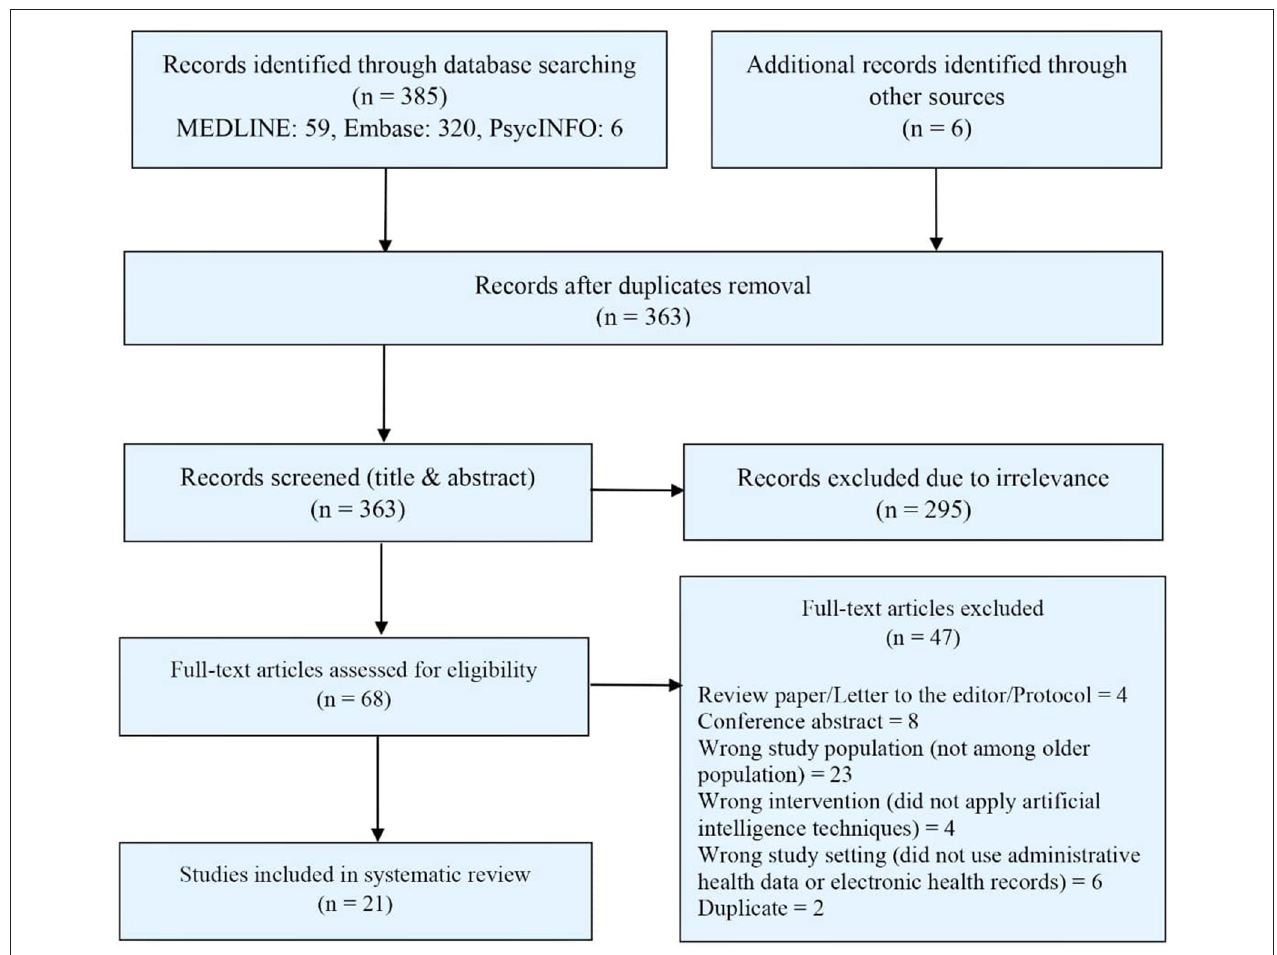
FIGURE 1 | PRISMA diagram for the systematic review of studies on artificial intelligence in geriatric mental health using EHR or